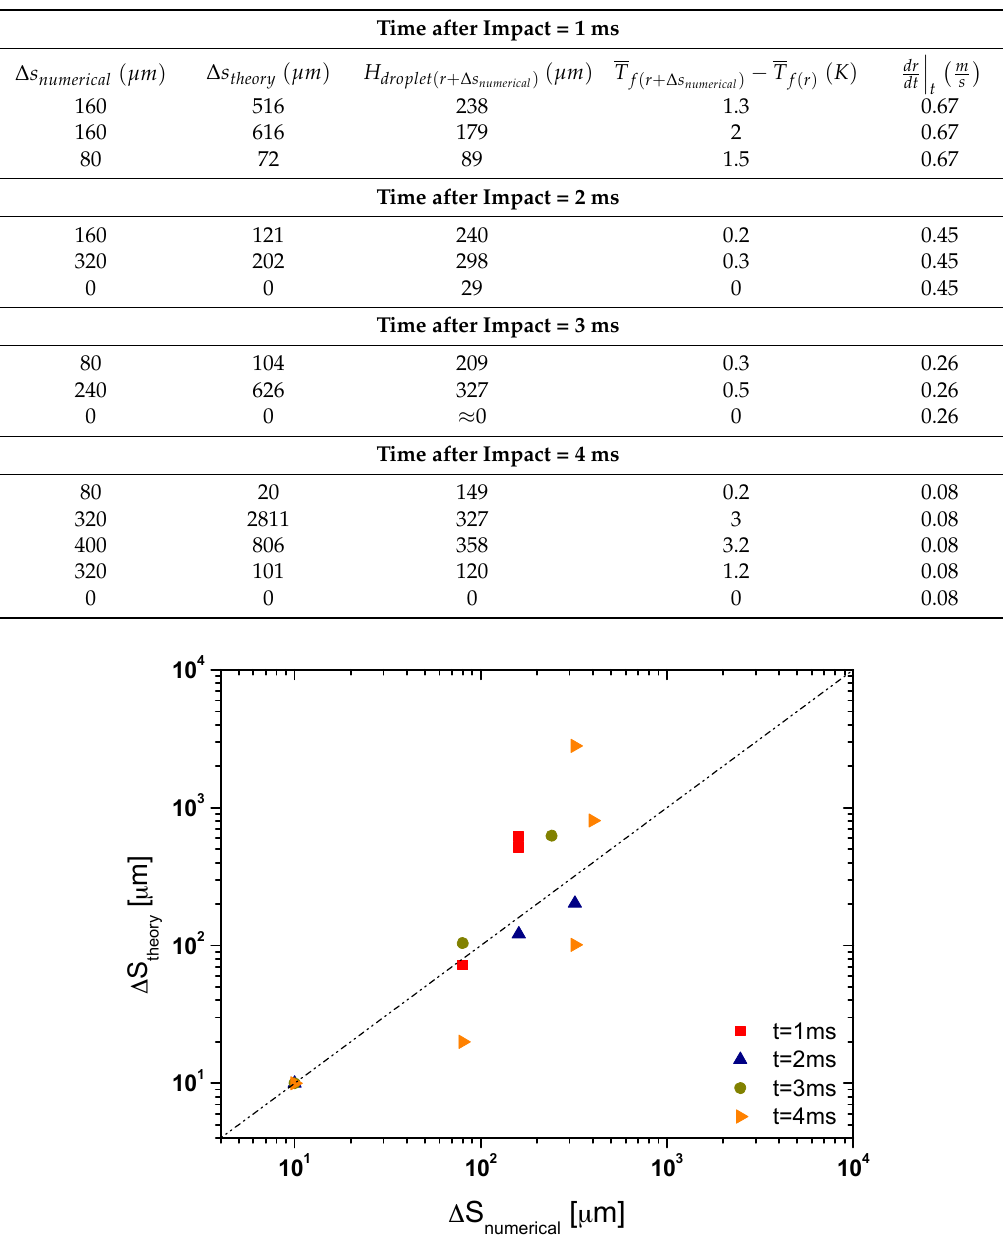
Table 5. Variables of interest and numerical versus theoretical shifts for We = 24 and Tw (in) = 353.15 K taken at 1, 2, 3 and 4 ms after droplet impact. Time after Impact = 1 ms